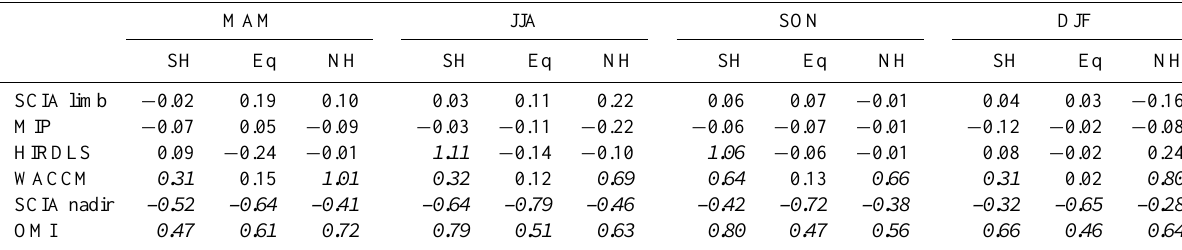
Table 3. Mean stratospheric column differences to limb reference (in 10 15 molecules cm − 2 , italicized if larger than 0.25). The latitude sectors